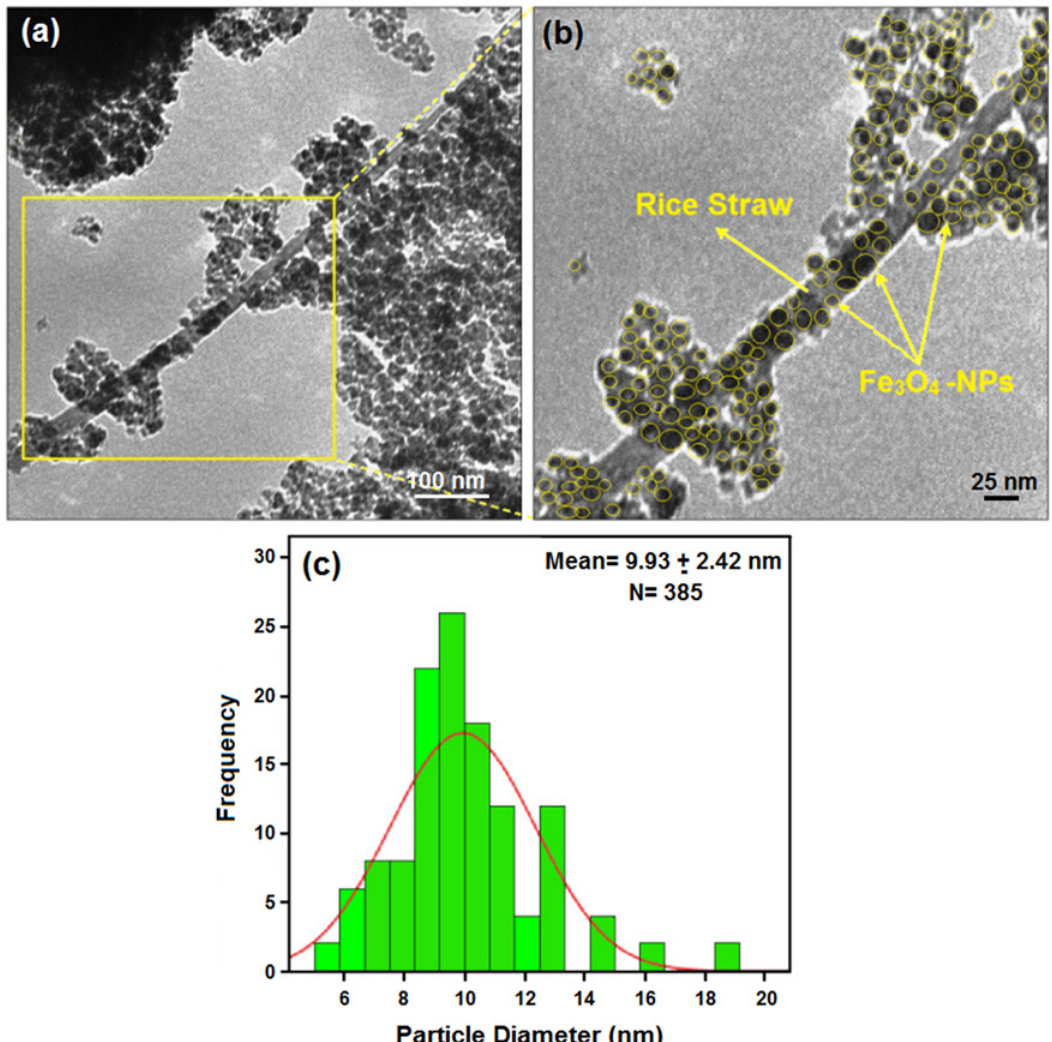
Fig 1. Transmission electron microscopy images and histogram of particle size distribution for rice straw/Fe 3 O 4